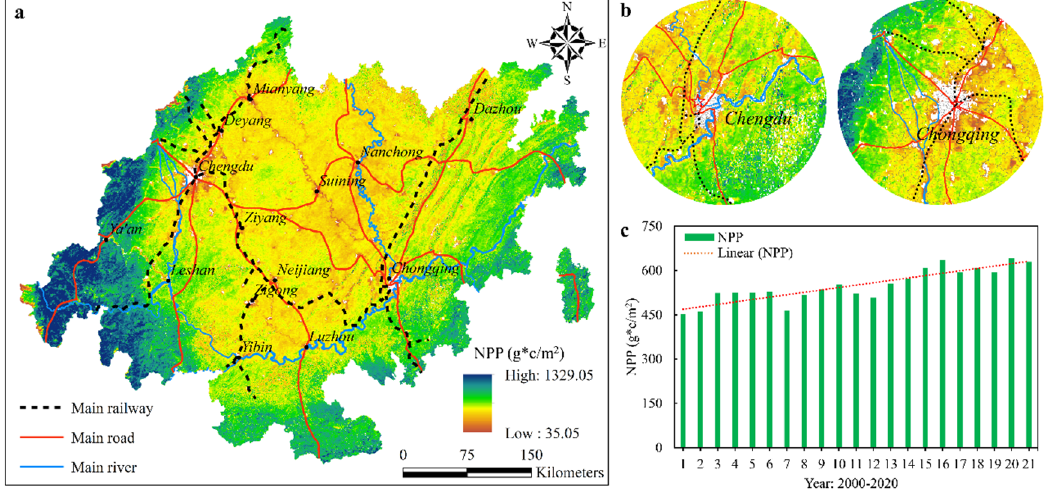
Figure 3. Average NPP distribution of CUA: 2000-2020 ( a ), NPP distribution of core cities ( b ), and temporal evolution trend of NPP ( c ). Land 2022 , 11 , x FOR PEER REVIEW